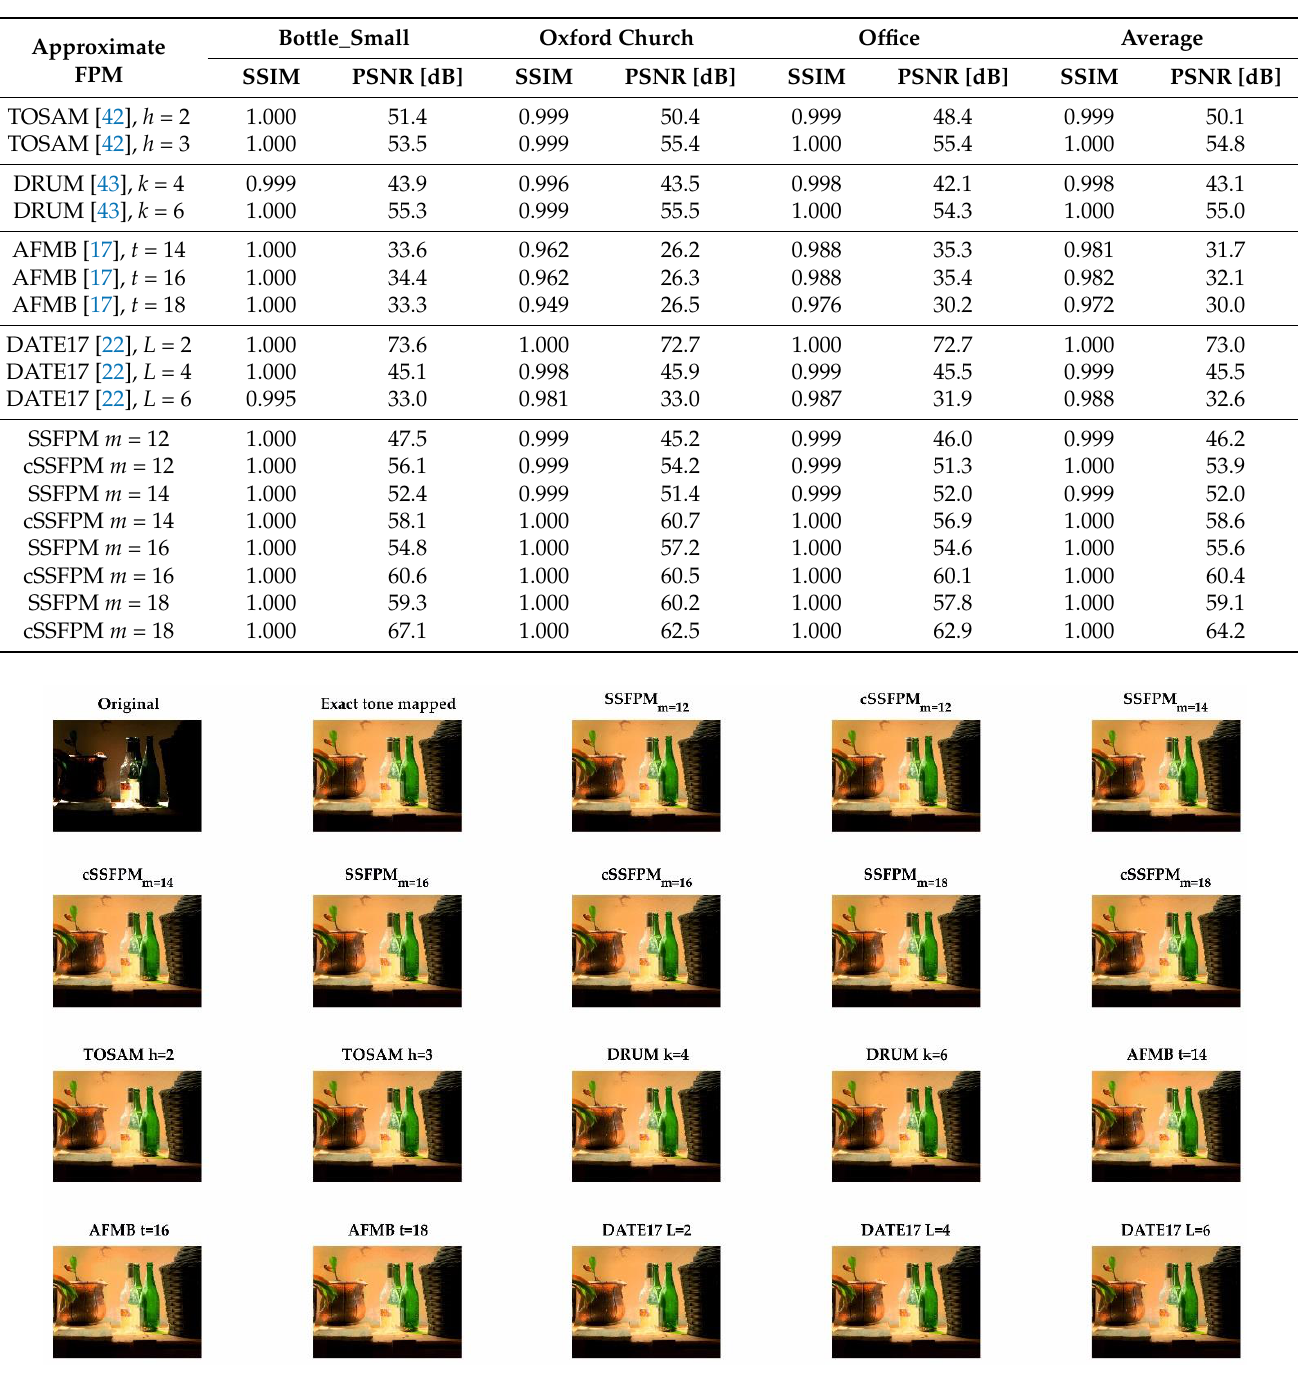
Figure 11. Example of tone mapping with the proposed segmented multipliers and the state-of-the-art. In this case, the SSIM achieved with the segmented multipliers is also very close to 1, and the PSNR ranges between 46 dB and 64 dB on average. The results are comparable Table 6. Results for tone mapping of HDR images. with [42,43], whereas the implementation [17,22] L = 6 exhibits lower performances (with PSNR up to 32.6 dB on